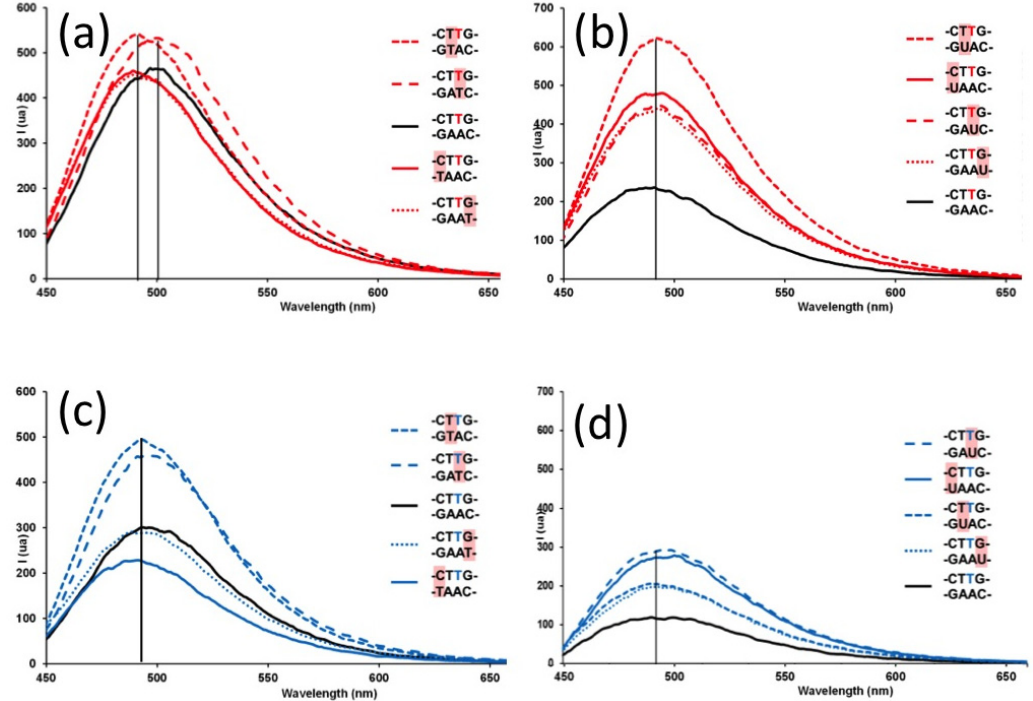
Figure 4. Fluorescence emission spectra ( λ 100 mM NaCl, 1 mM EDTA, pH = 7) of ODN3 (dye labelled thymidine in red) with DNA ( a ) or RNA ( b ) and of ODN5 (dye labelled thymidine in blue) with DNA ( c ) or RNA ( d ) single mismatched counterparts,